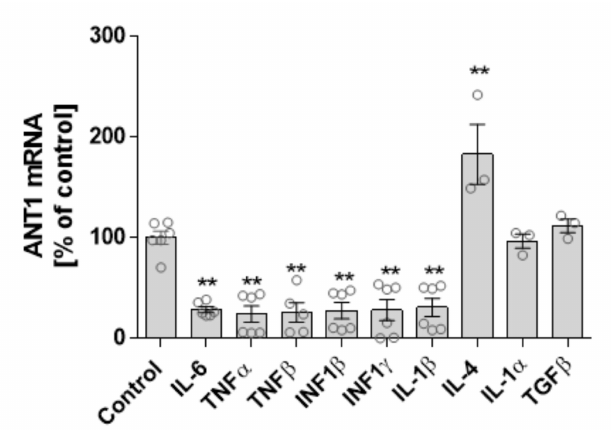
Figure 5. Relationship between ANT1 and cytokine transcription. Isolated neonatal rat cardiomy- ocytes were treated with various cytokines for 24 h. mRNA levels of treated cells were determined by quantitative PCR. Data are shown as mean ± SEM, ** p ≤ 0.01 vs. untreated